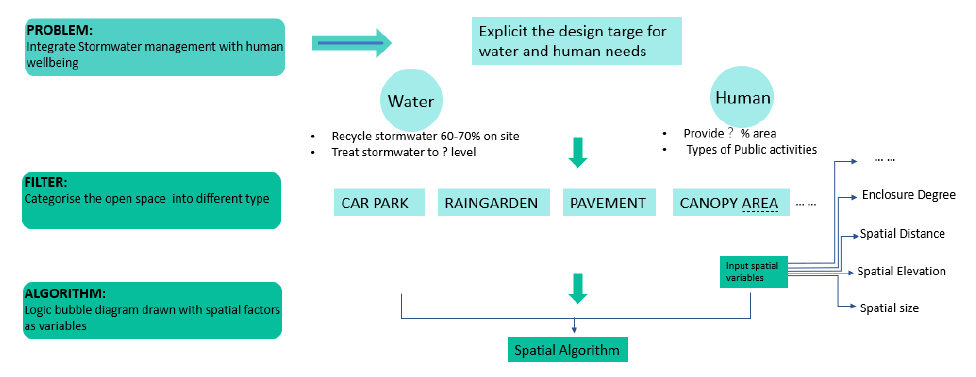
Figure 6. Schematic diagram of entire workflow of integrating stormwater and human wellbeing within one parametric